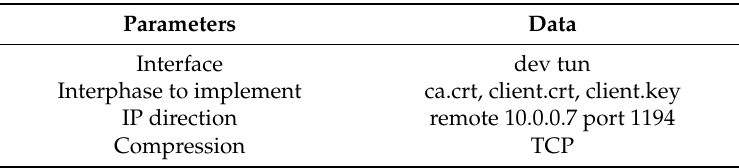
Table 4. Client configuration